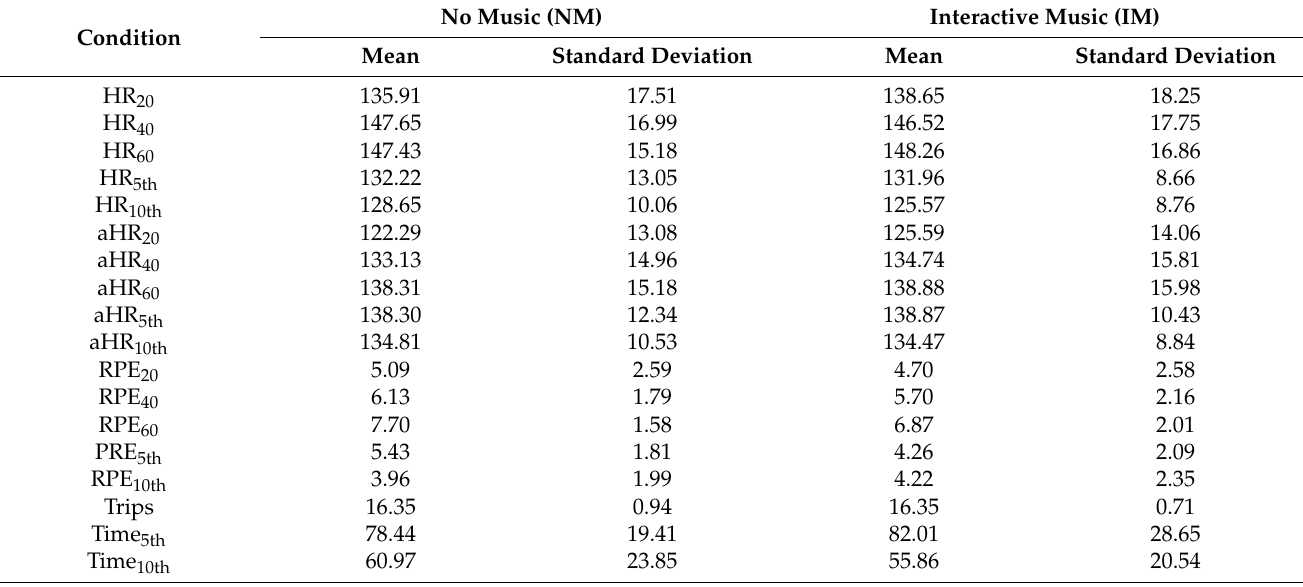
Table 4. Descriptive statistics for HR, aHR, RPE, Trips, and Goal-Time during tasks with IM and NM